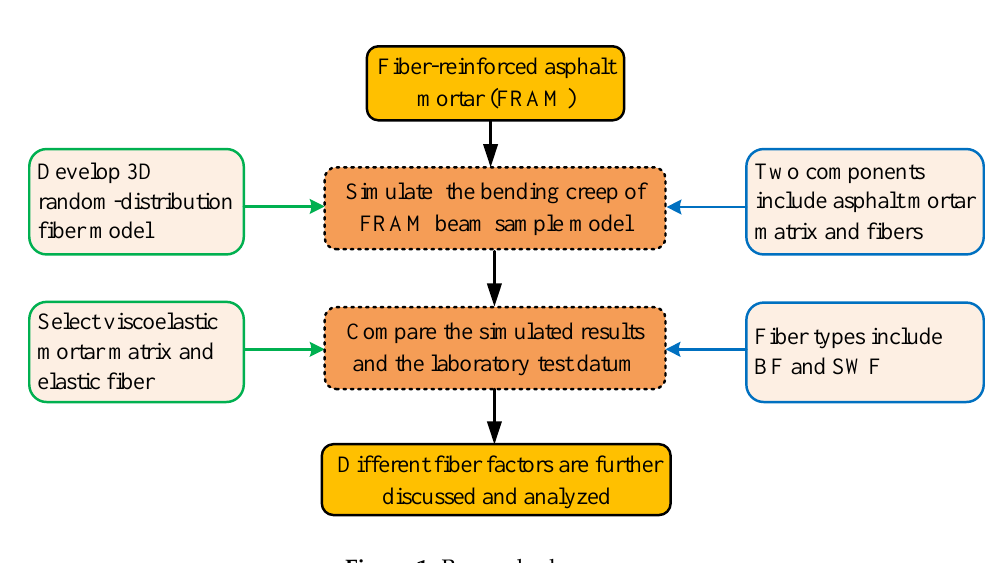
Figure 1. Research plan process.